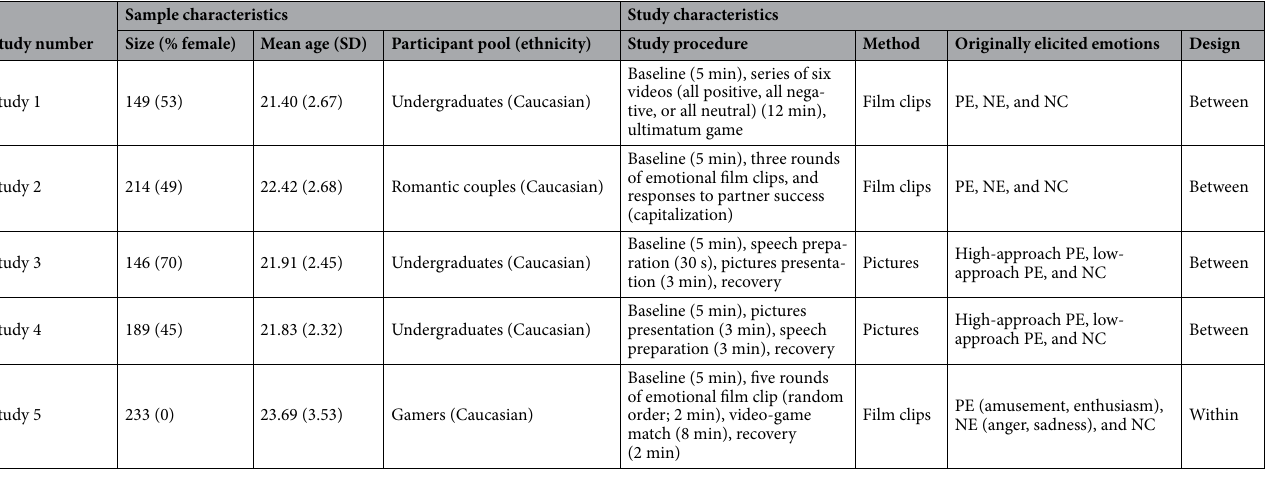
Table 1. Overview of studies characteristics. PE positive emotions, NE negative emotions, NC neutral